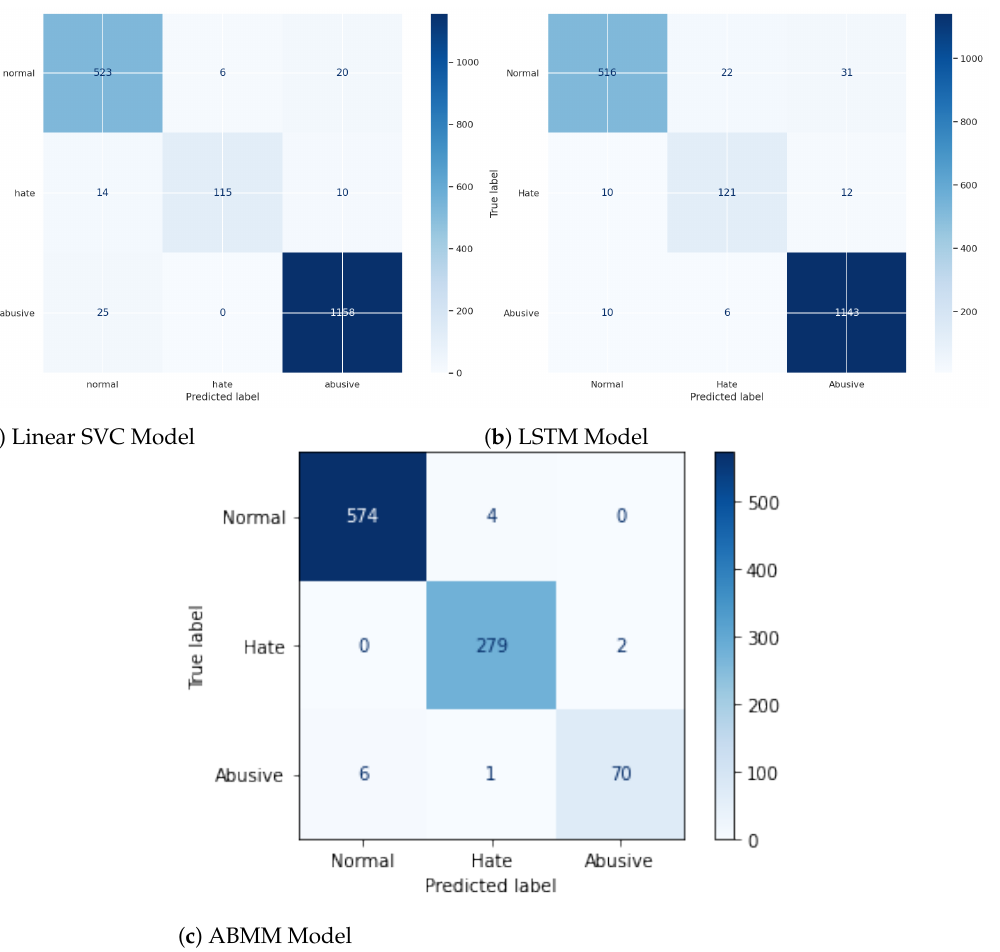
Figure 7. Confusion matrices for the top